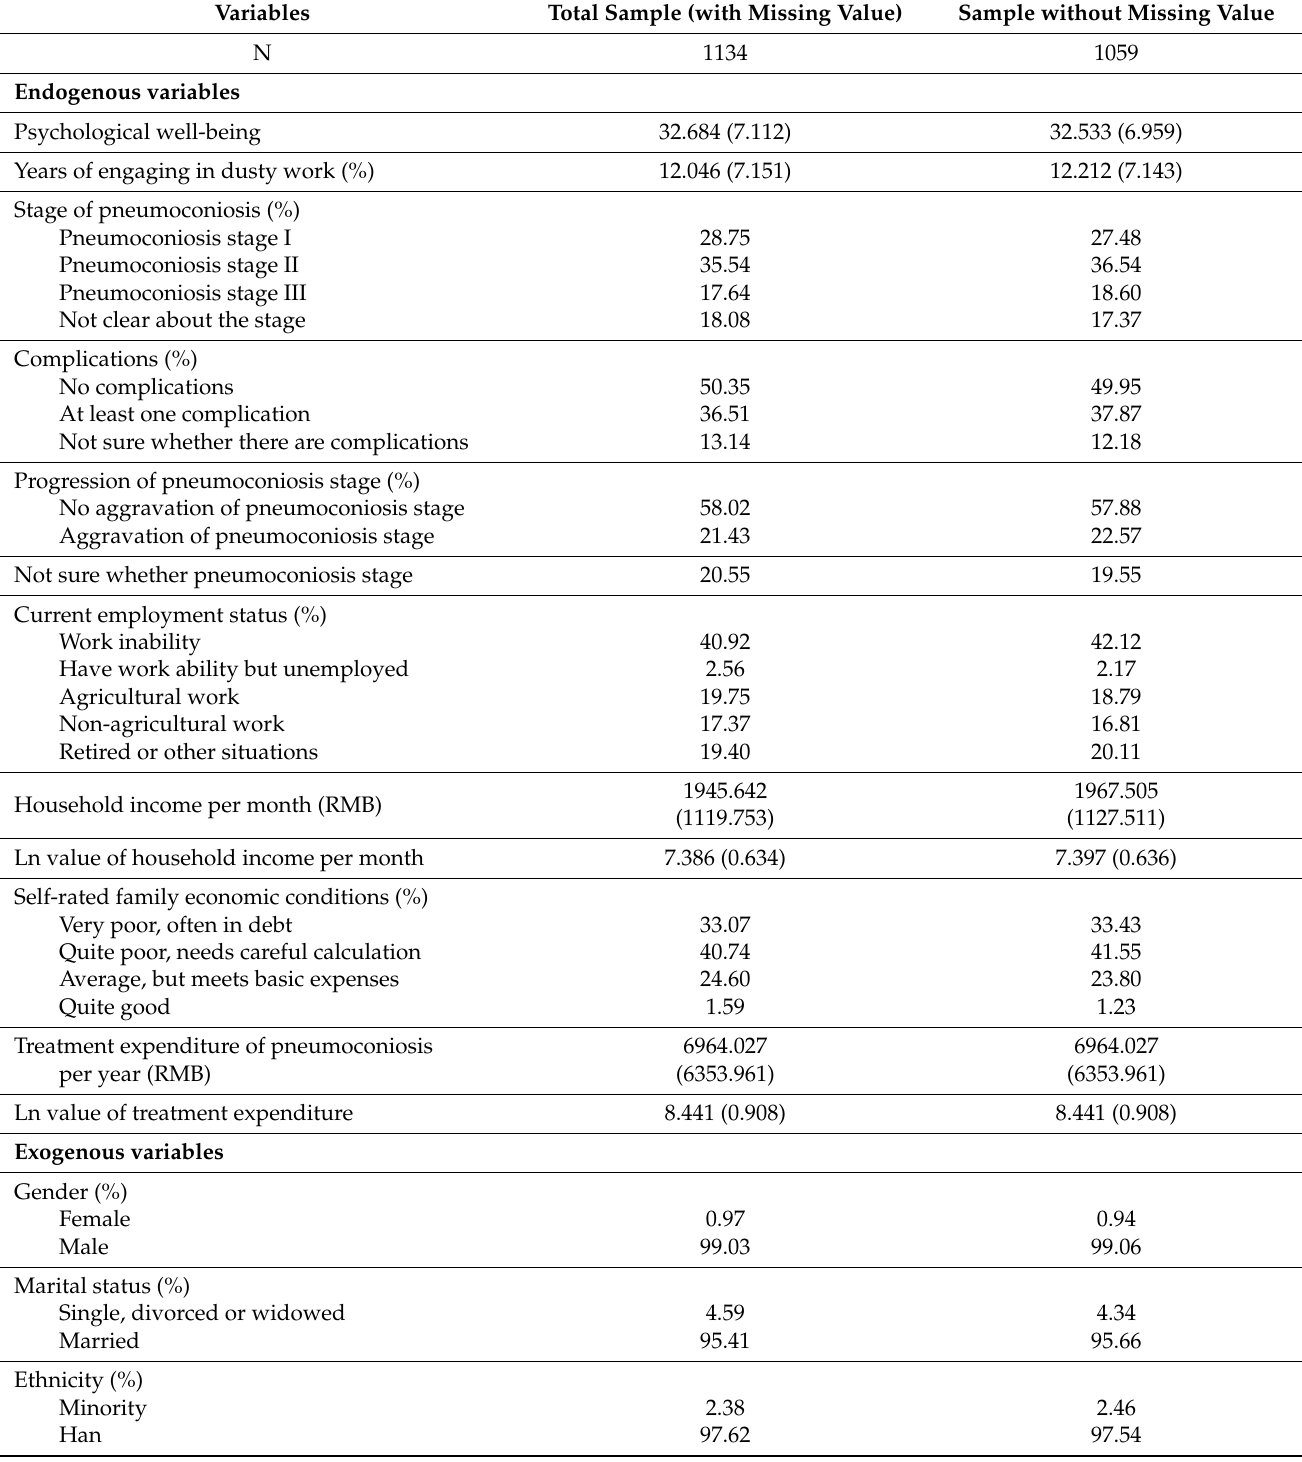
Table 1. Descriptive Statistics of the Analysis